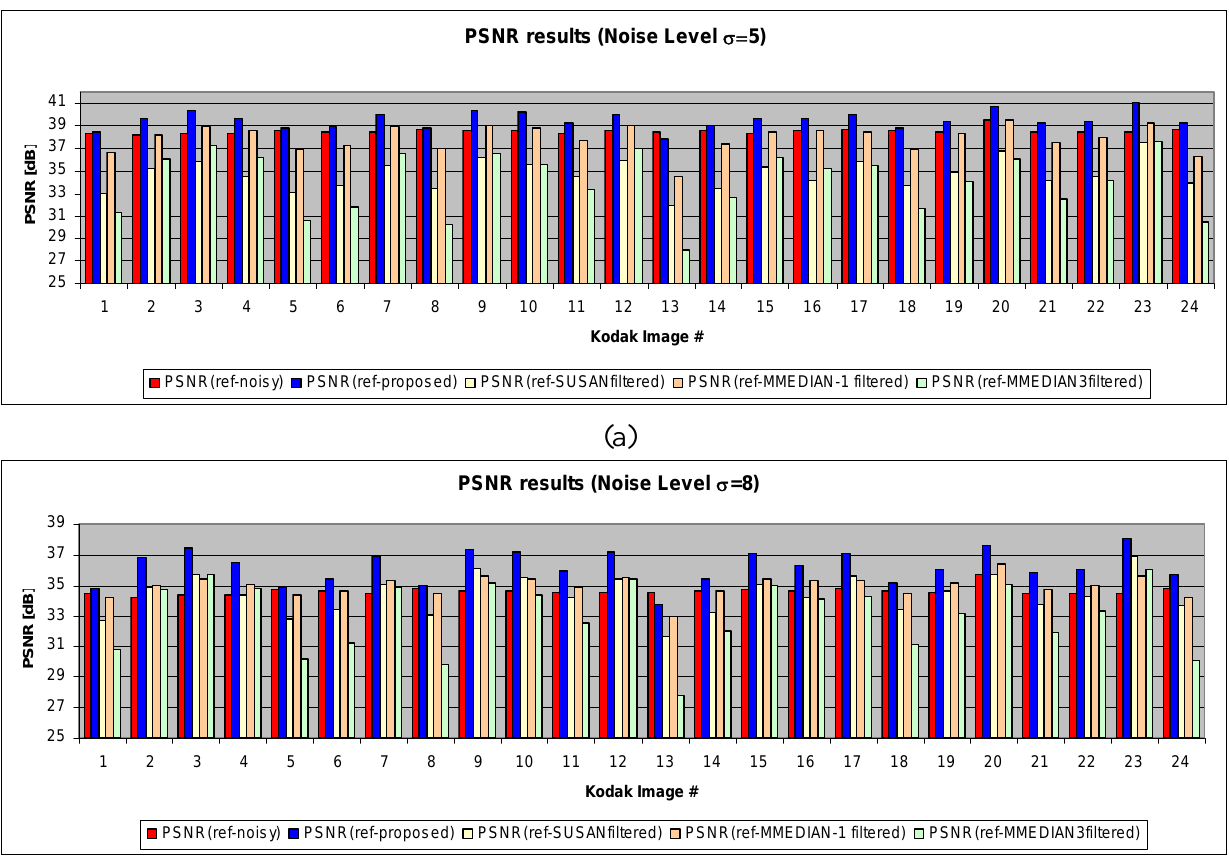
Figure 20. PSNR comparison between proposed solution and other spatial approaches for the Standard Kodak Images test set. (a) Kodak noisy images set with standard deviation 5. (b) Kodak noisy images set with standard deviation 8. (c) Kodak noisy images set with standard deviation